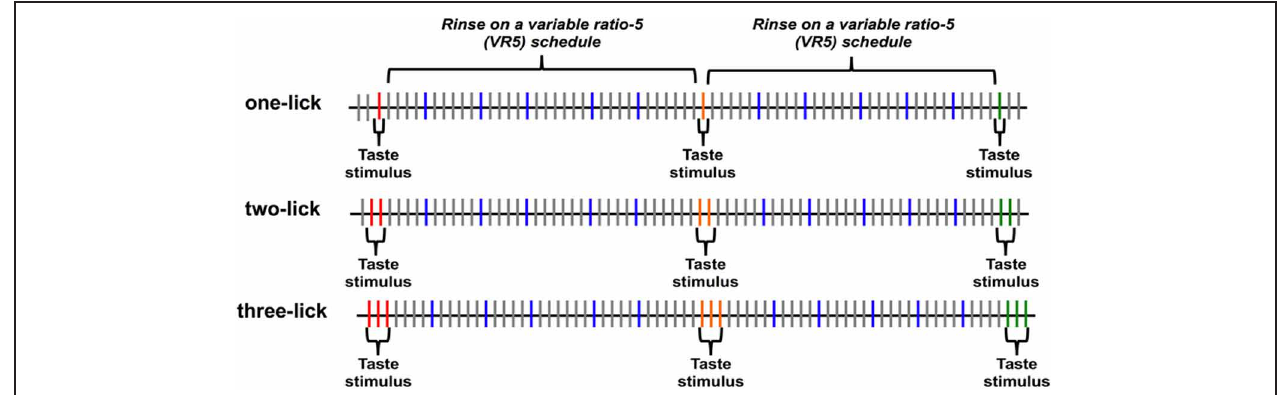
FIGURE 1 | Diagram of the stimulus presentation paradigm. Taste stimuli were presented for one, two, or three licks depending on the session, followed by five water rinse licks, with each rinse lick on a variable ratio 5